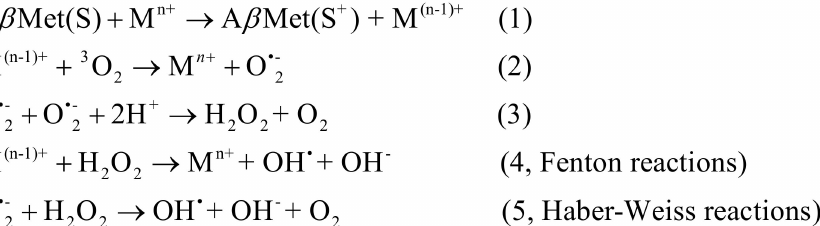
Scheme 6. Examples of redox reactions involving ROS, metals (Mn + ) and β -amyloid protein (A β )